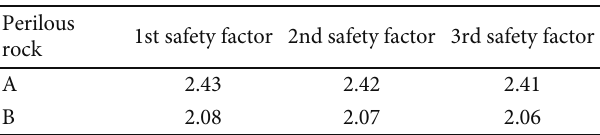
Table 3: Measurement results of natural vibration frequency of perilous